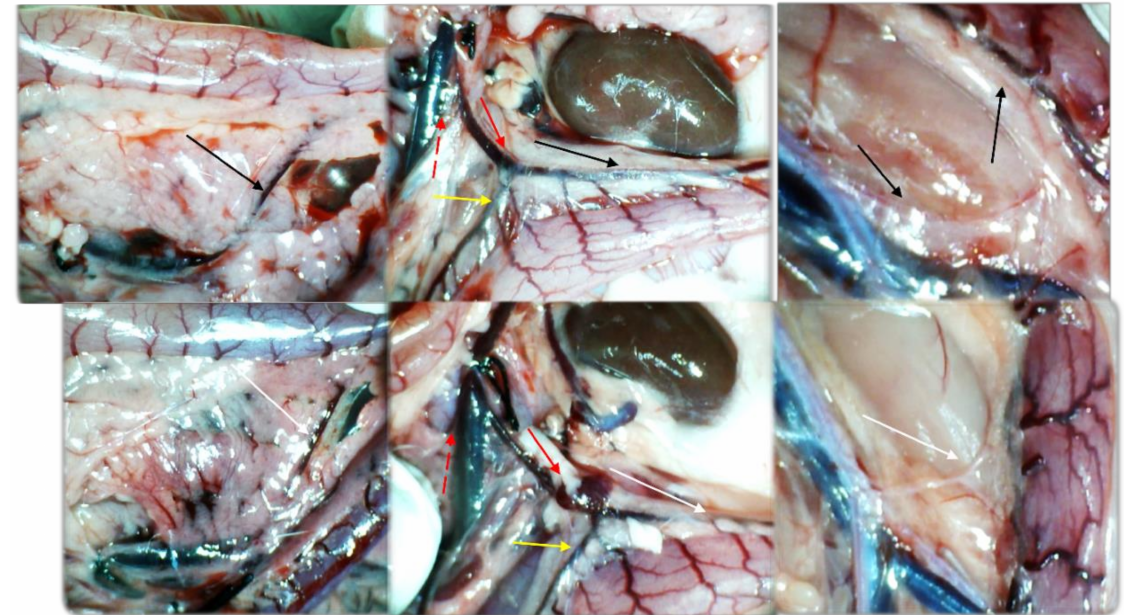
Figure 8. Illustrative gross vessel presentation in the rats with the occluded superior mesenteric vein and artery, without therapy (low, control) and BPC 157 therapy (upper, 10 ng/kg, providing the same presentation with the 10 µ g/kg). Left. Inferior anterior pancreaticoduodenal vein (dashed arrow (black (BPC 157), white (control)) with prominent duodenal congestion (low, control). Reestablished blood flow (upper, BPC 157), congestion, and vascular failure (low, control). Middle. Superior mesenteric vein (red dashed arrows), inferior mesenteric vein (full red arrows), middle colic vein (yellow arrows), left colic vein (black (BPC 157), white (control) distal from occlusion. Tinny veins of the transverse colon (low, control), and exaggerated veins indicating activated collaterals (BPC 157) as a part of the reestablished blood flow to compensate for occlusion (upper, BPC 157). Right. Inferior mesenteric artery and abdominal aorta with presentation close to normal (black arrows (BPC 157), or tinny empty inferior mesenteric artery and abdominal aorta (low, control). Tortuous veins presentation of the rectal veins (control, low). Camera attached to a VMS-004 Discovery Deluxe USB microscope (Veho, Dayton, OH,